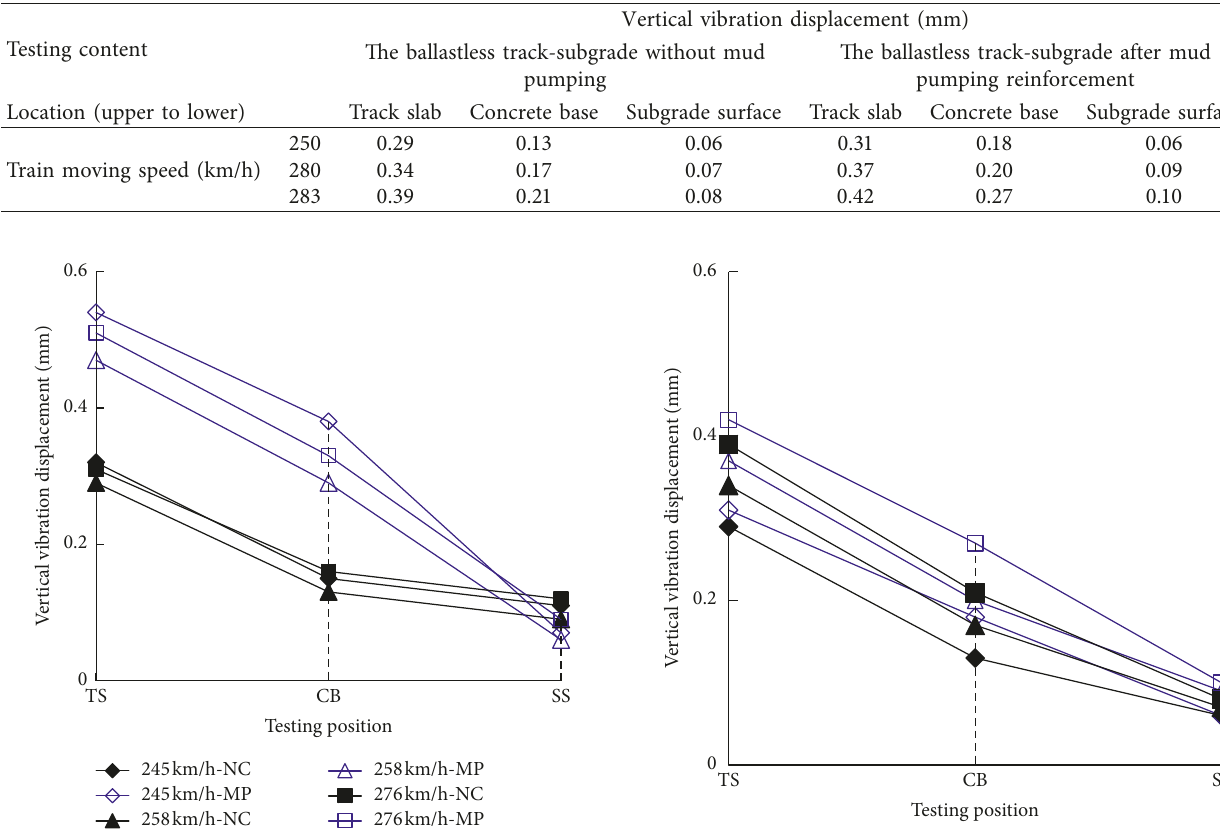
Figure 13: The distribution of the vertical vibration displacement of the ballastless track-subgrade with and without mud pumping.